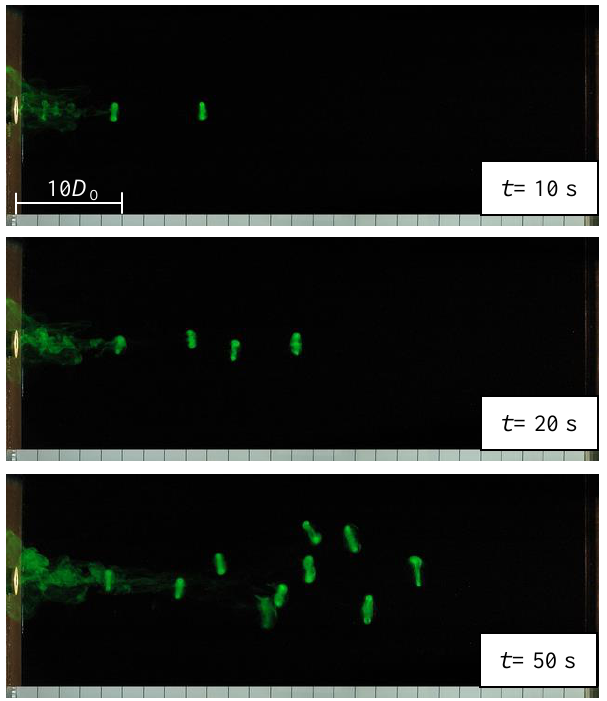
Fig. 5 Successive visualization of vortex rings with swirl (  = 0.5  rad/s) in case